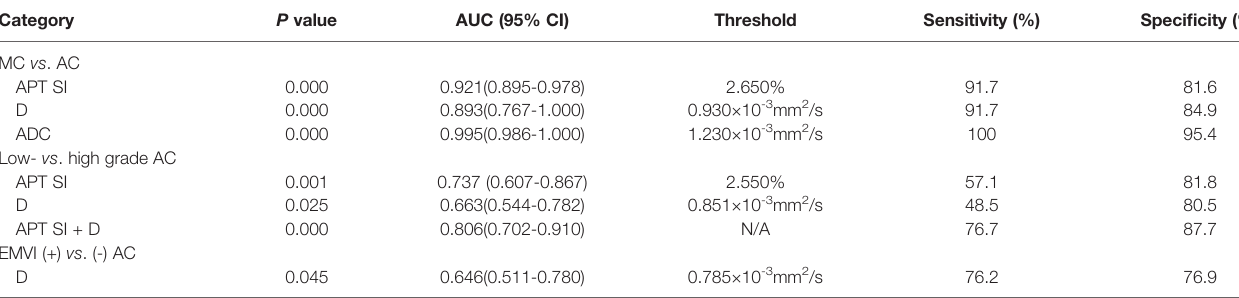
TABLE 5 | Diagnostic performance of APT SI, D and ADC values with signi fi cant difference between